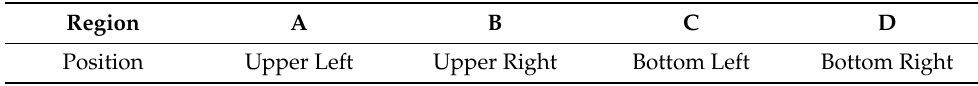
Table 1. The position of each region.